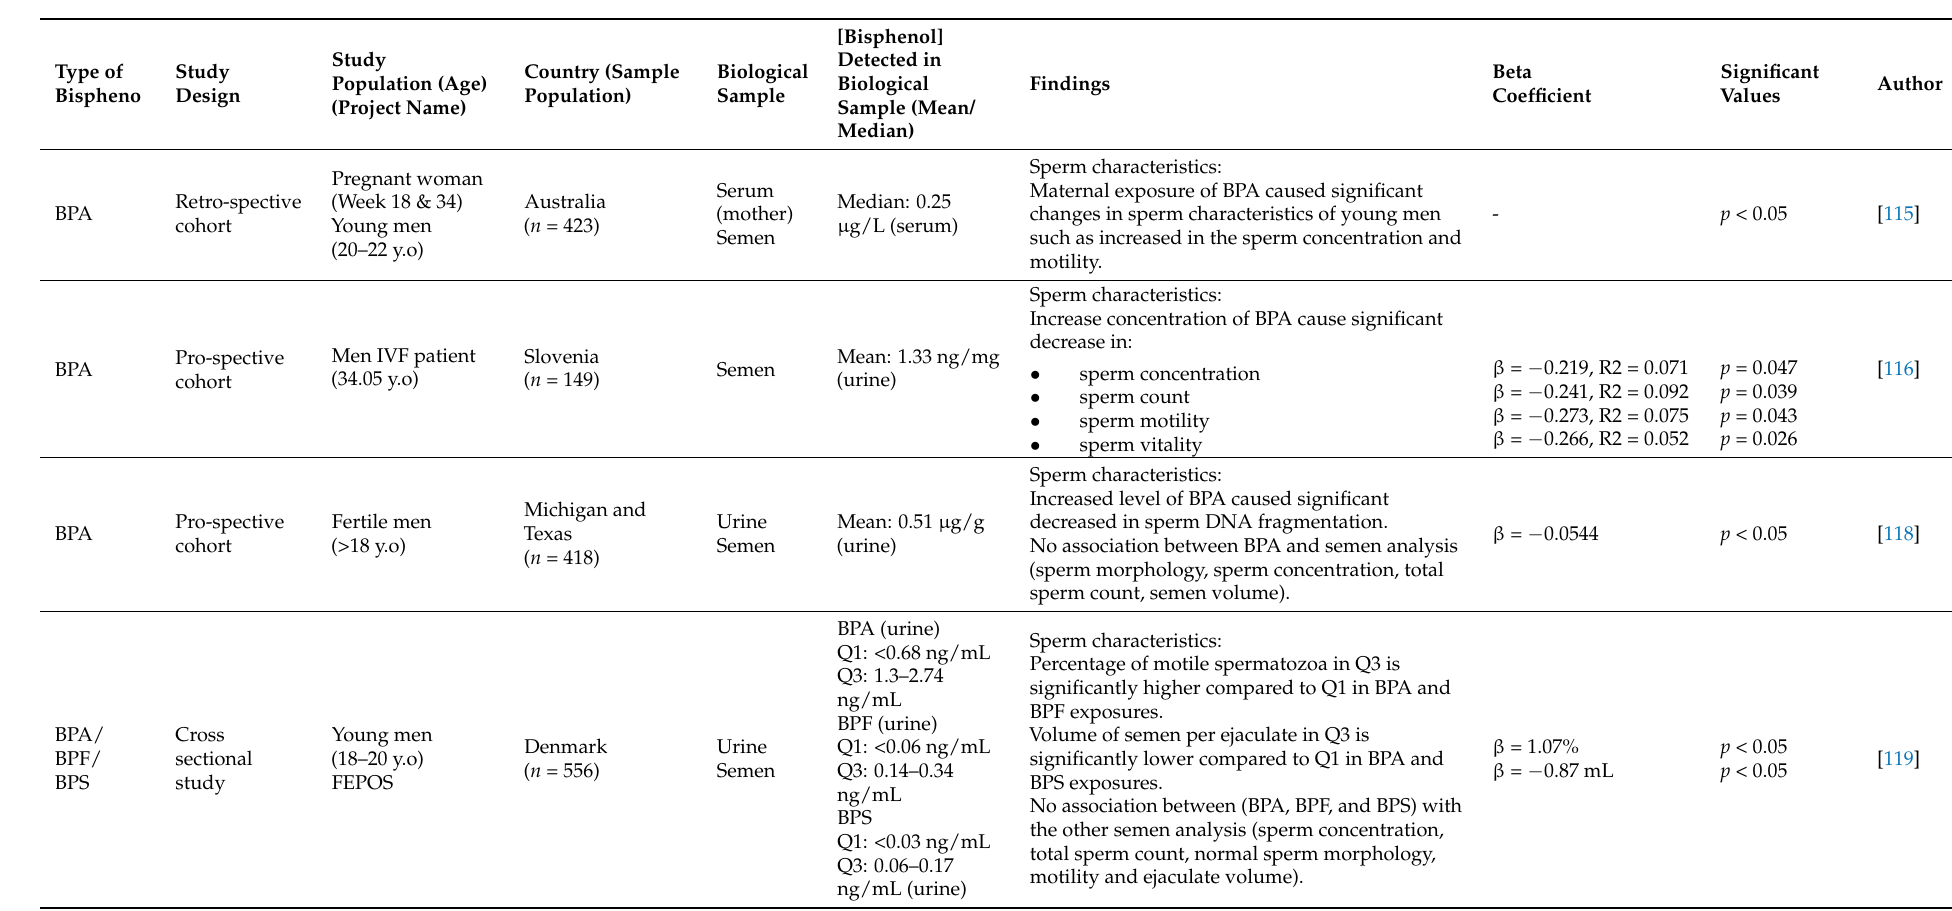
(sperm morphology, sperm concentration, total sperm count, semen volume). Sperm characteristics: Percentage of motile spermatozoa in Q3 is significantly higher compared to Q1 in BPA and BPF exposures. Volume of semen per ejaculate in Q3 is significantly lower compared to Q1 in BPA and BPS exposures. No association between (BPA, BPF, and BPS) with the other semen analysis (sperm concentration, total sperm count, normal sperm morphology, motility and ejaculate